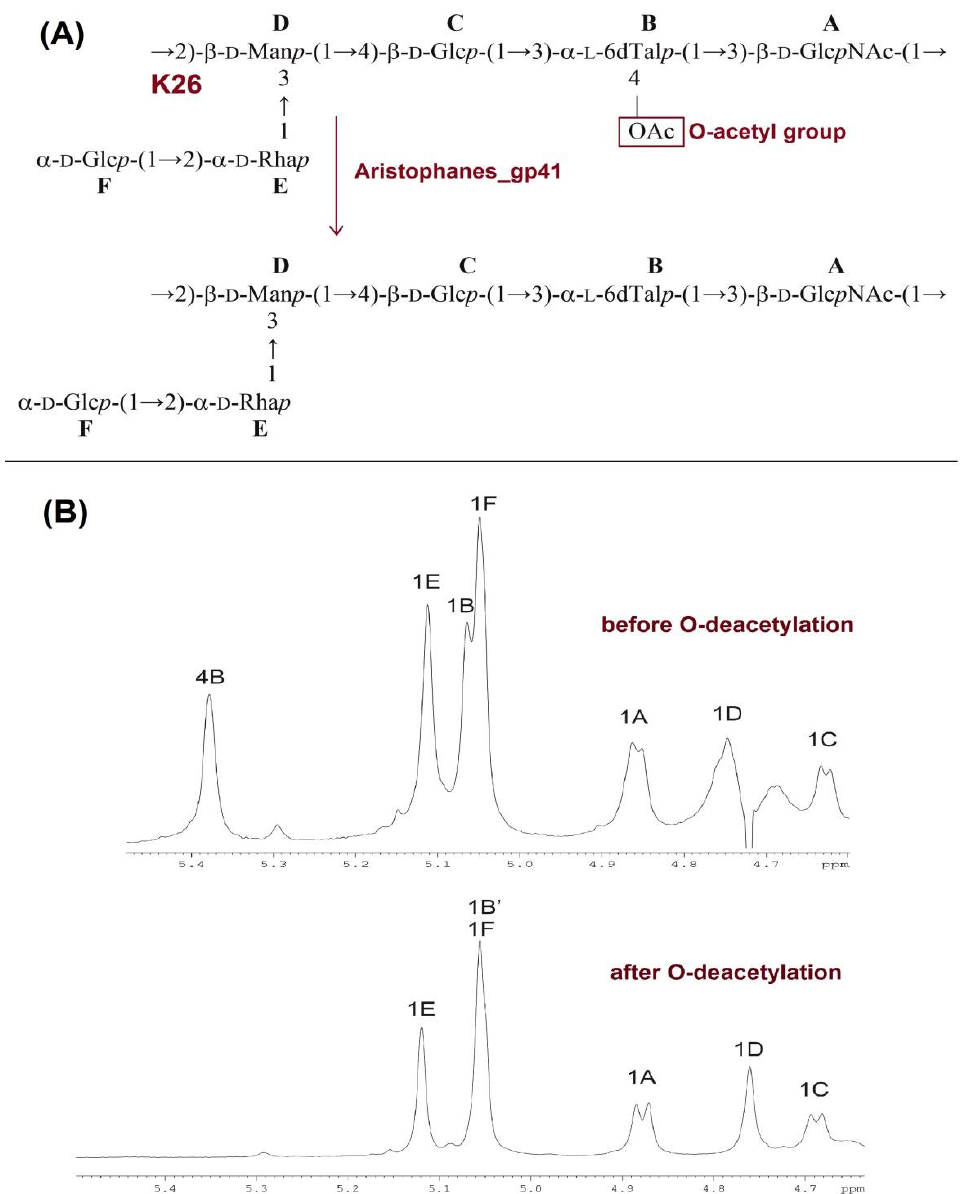
Figure 7. ( A ) Structures of the CPS of A. baumannii KZ1098 before and after O-deacetylation. ( B ) Parts of 1 H NMR spectra of the A. baumannii KZ1098 CPS before and after O-deacetylation (MPS). Treatment of the K26 CPS with Aristophanes_gp41 caused no changes to the NMR spectral data of the constituent sugar residues except for 6-deoxytalose (6dTal) (unit B). An unusual low-field position of the H-4 signal of 6dTal at δ H 5.38 was observed in the CPS and accounted for by 4-O-acetylation of this sugar residue. Treatment with the phage